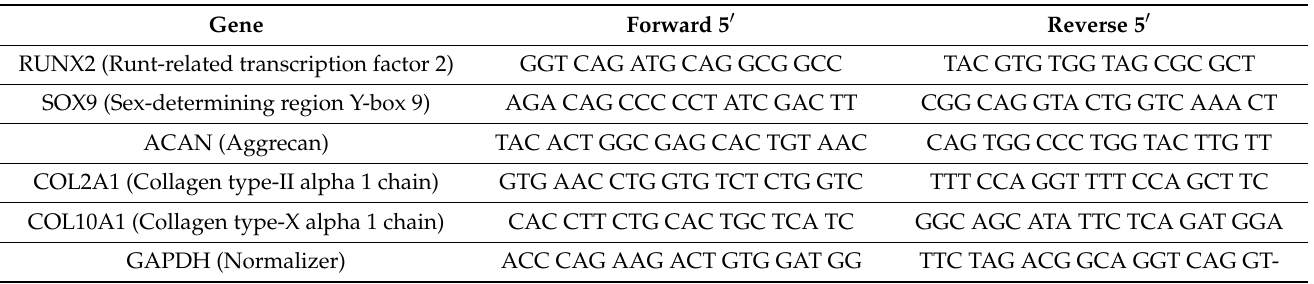
Table 1. Primer sequences used in RT-qPCR experiments. GAPDH was used as an endogenous normalizer in relative expression